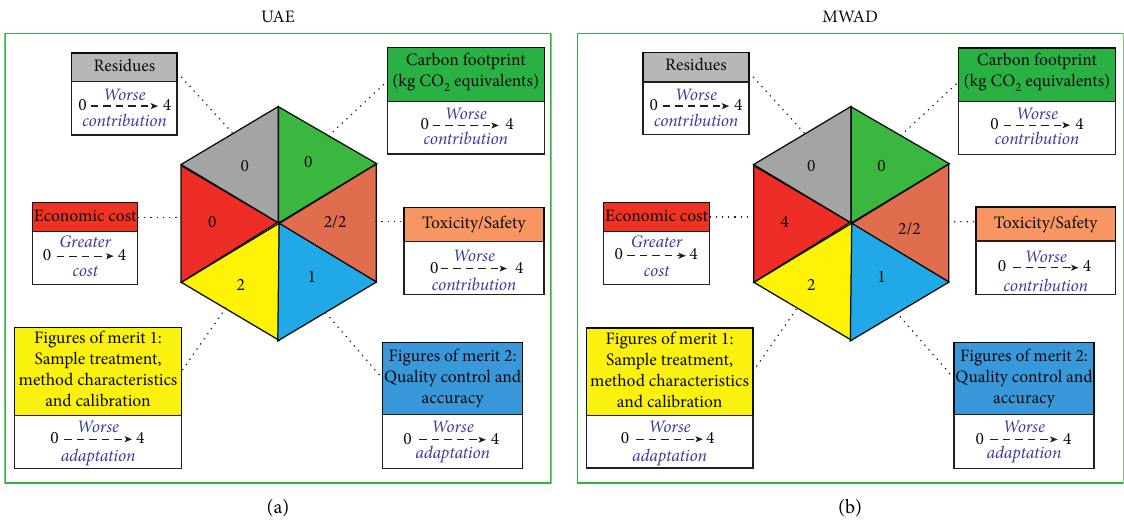
Figure 1: Comparison of Green Analytical Procedure Index for (a) UAE and (b) MWAD sample preparation.